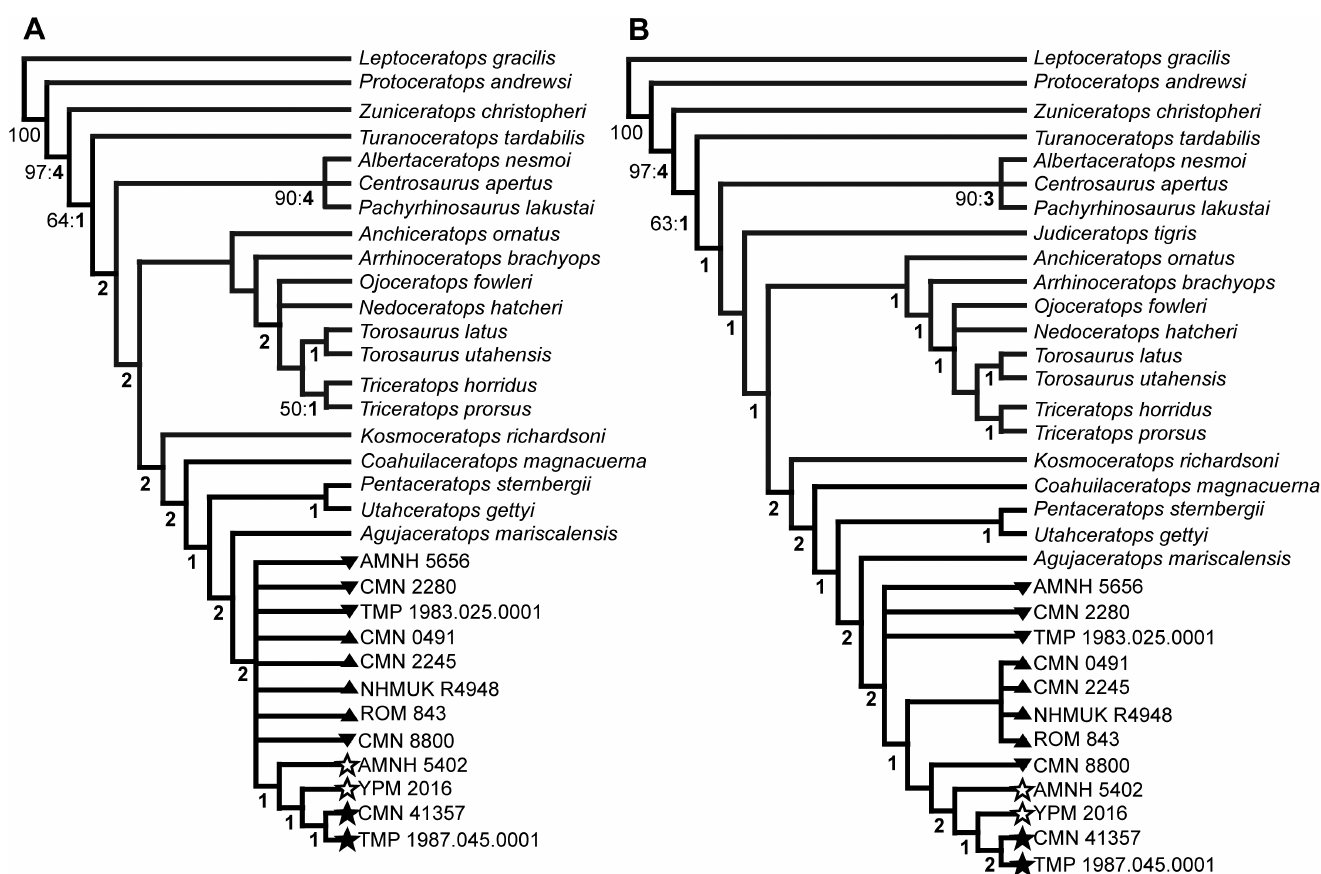
Figure 3. Specimen-based phylogenetic analyses of Chasmosaurus and ‘ Vagaceratops ’ specimens. A) Strict consensus tree of Campbell et al. (2016: fig. 5D, modified), excluding Bravoceratops , Eotriceratops , Judiceratops , and specimens missing the diagnostic posterior parietal region (AMNH 5401, CMN 1254, ROM 839, TMP 1981.019.0175, and UALVP 40); 5410 most parsimonious trees (MPTs), tree length (TL) = 276 steps, consistency index (CI) = 0.64, retention index (RI) = 0.76). B) Strict consensus tree with same taxa and specimens excluded, except for Judiceratops , and with revised recodings for AMNH 5402 (see text); 1530 MPTs, TL = 291 steps, CI = 0.63, RI = 0.76). Bootstrap replicate frequency and Bremer support (bold) values are shown below each node; only Bootstrap values of 50% or higher are given. ‘ Vagaceratops ’ irvinensis (solid black stars), ‘ V .’ irvinensis -like Chasmosaurus sp. (empty black stars), C. belli (triangles), and C. russelli (inverted triangles) specimens.